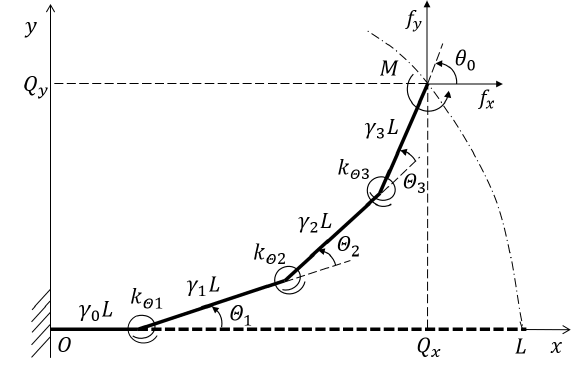
Figure 9. 3R pseudo-rigid-body model.